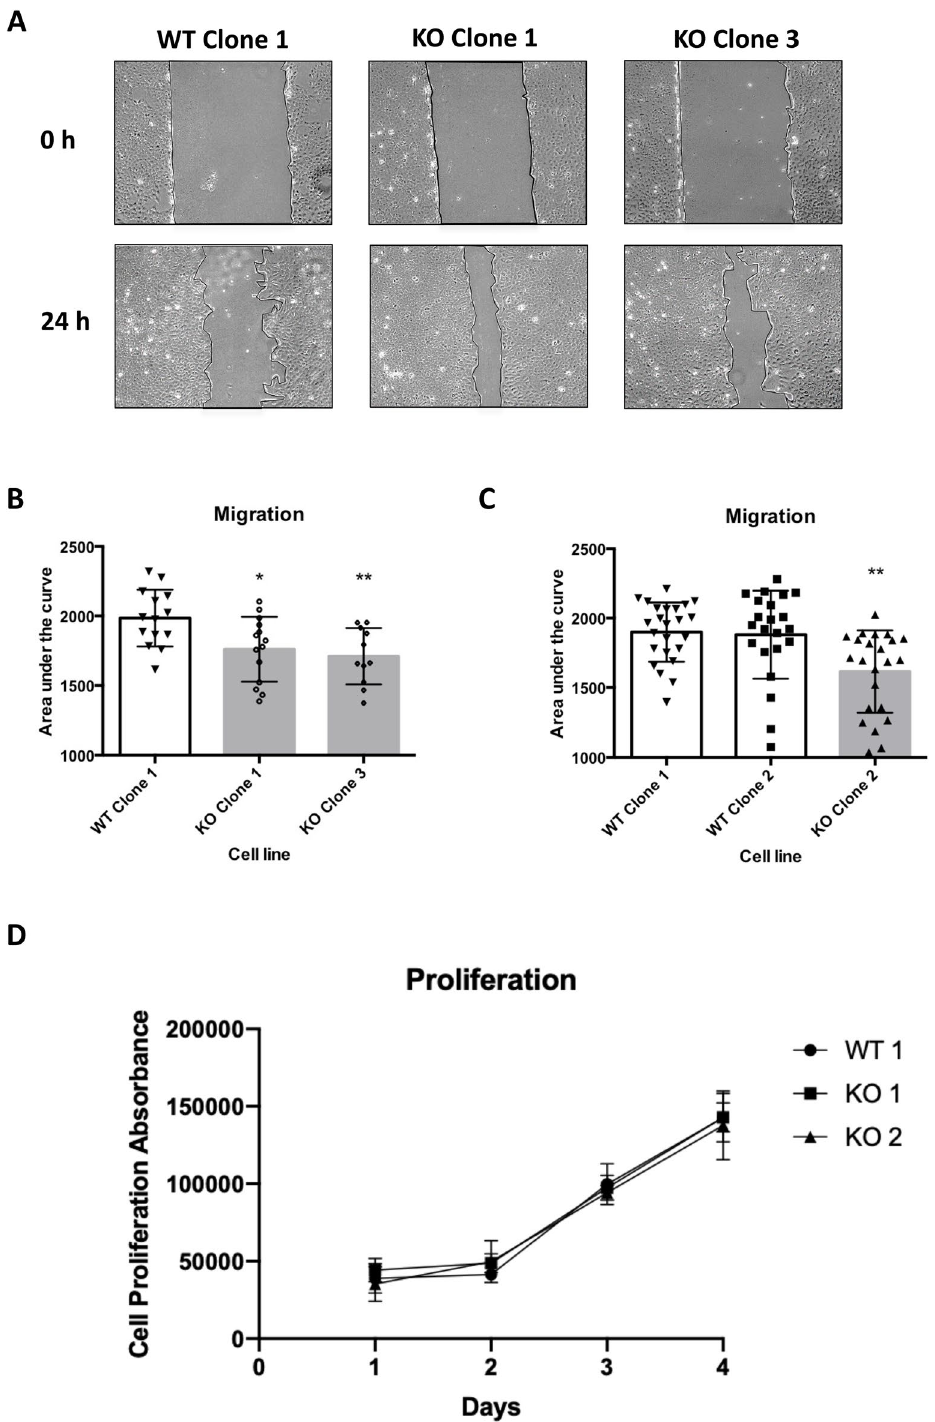
Figure 3. XIAP-null cells have increased migratory capacity. ( A ) Representative images of a wound healing experiment for wild type and XIAP null clones at 0 and 24 h. The migration front is highlighted for clarity. ( B ) The area of the wound was imaged and measured at 0, 8, and 24 h using ImageJ software. The data was normalised with the percentage wound area equalling 100% at 0 h. The % wound area was plotted against time and the area under the curve (% wound area × time(hours)) was calculated and analysed by one-way ANOVA using Dunnett multiple comparisons test in comparison to the wildtype clone 1. Each measurement represents data from an individual scratch. Statistical analysis performed using a one-way ANOVA with Dunnett’s multiple comparisons test ( C ) As in B. using independent XIAP-null clonal cell lines. ( D ) Proliferation assay performed using Prestoblue assay. Cell lines and measurement times as